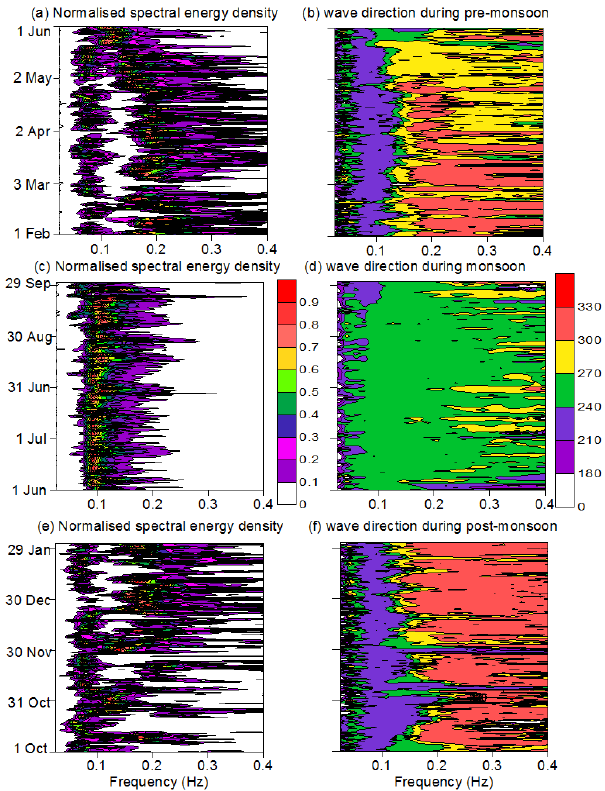
Fig. 9. Normalised spectral energy density and mean wave direction Figure 9: Normalised spectral energy density and mean wave direction during pre-monsoon (a,b), 500 during premonsoon (a, b) , monsoon (c, d) and postmonsoon (e, f) monsoon (c,d) and post-monsoon (e,f) period 501